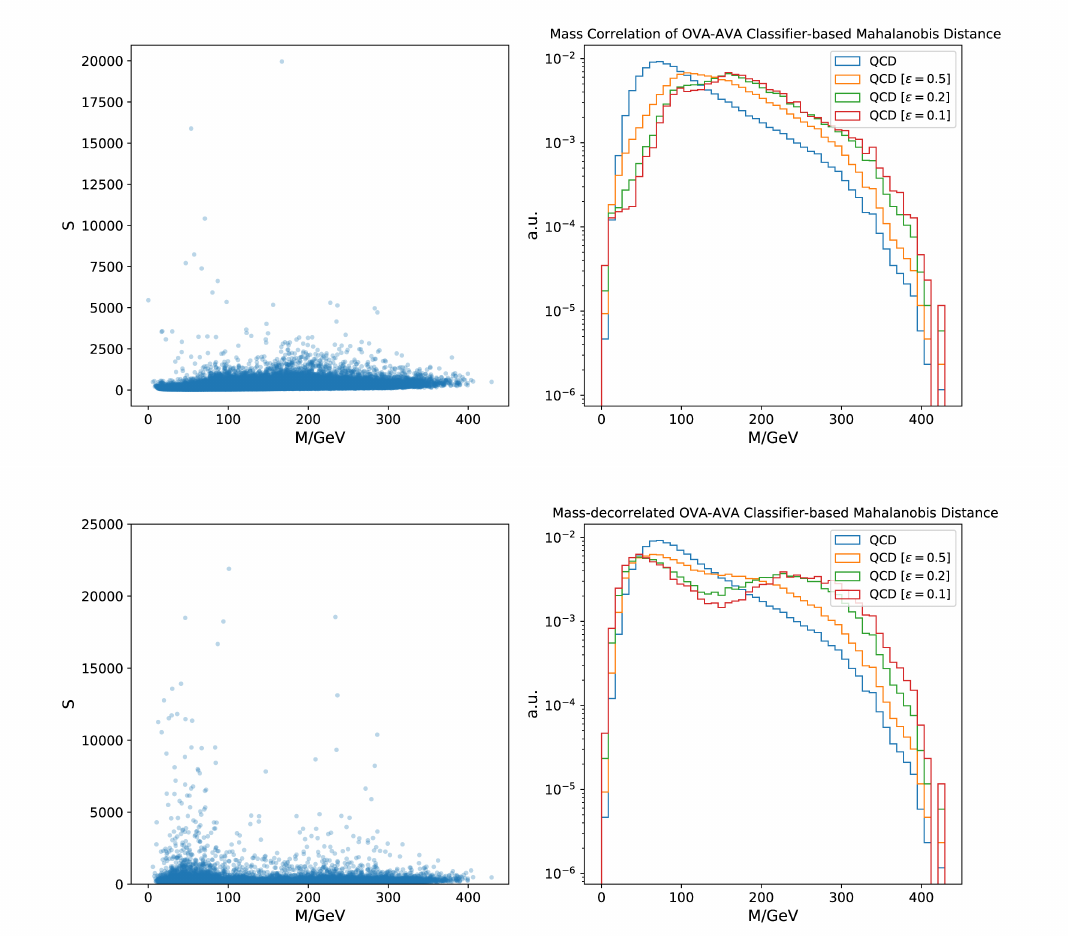
Figure 12 . OVA-AVA Model. Top : The un-decorrelated model with the Mahalanobis distance as the anomaly score. Bottom : The mass-decorrelated model with the Mahalanobis distance as the anomaly score. Left : The correlation between jet mass M and the anomaly score. Right : Mass distributions for different background acceptance rates ( (cid:15)